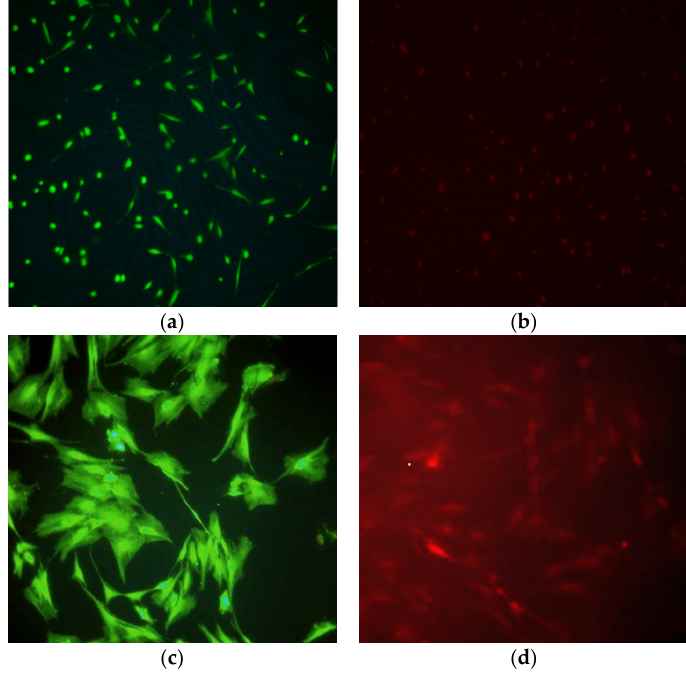
Figure 5. Cellular viability observed by LIVE/DEAD ® analysis.( a ) Live cells on ITO; ( b ) Dead cells on ITO; ( c ) Live cells on ITO-ODT and ( d ) Dead cells on ITO-ODT after 48 h (Bar represents 10 µ m).